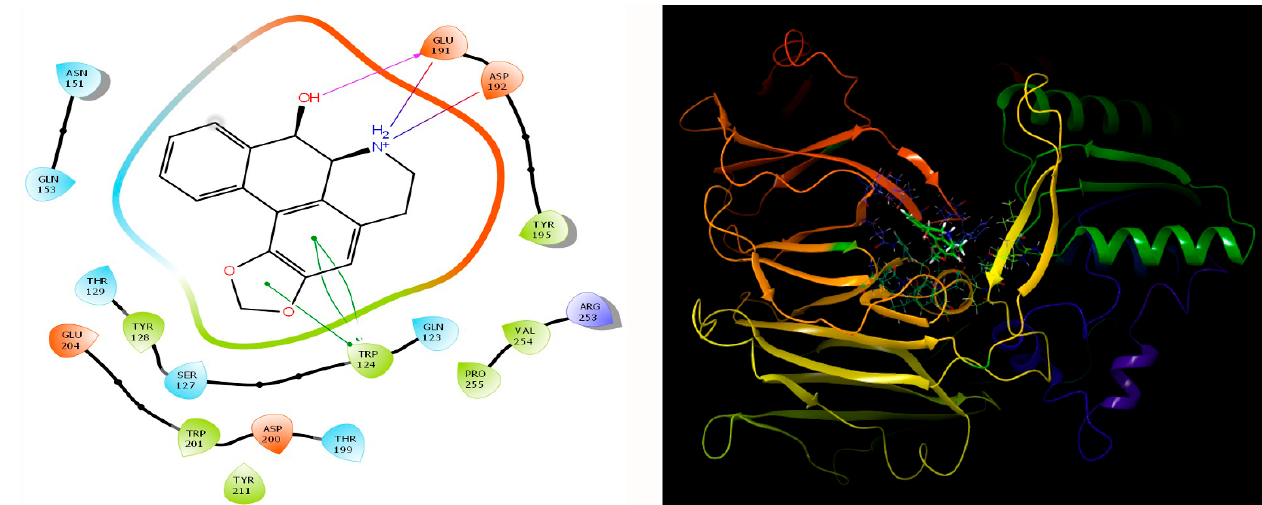
Molecules 2022 , 27 , x FOR PEER REVIEW Figure 2. Interaction of human DPP-4 (PDB ID-2ONC) with michelalbine. Figure 2. Interaction of human DPP-4 (PDB ID-2ONC) with michelalbine.